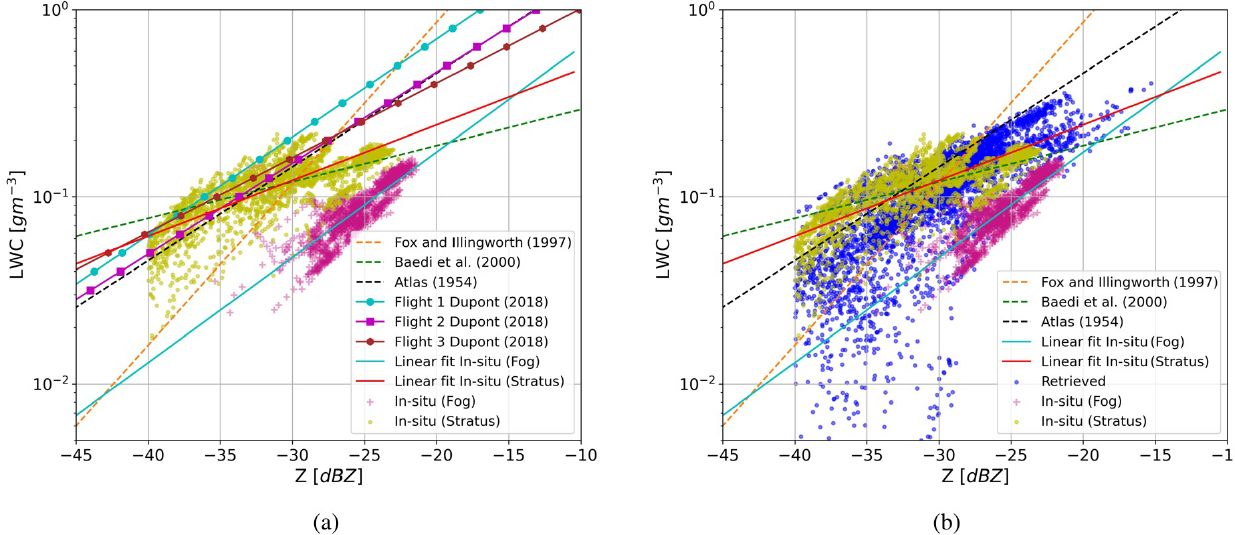
Figure 9. Comparison of in situ LWC and radar reflectivity relation with the (a) available literature for fog and clouds, (b) retrieved LWC and BASTA radar reflectivity